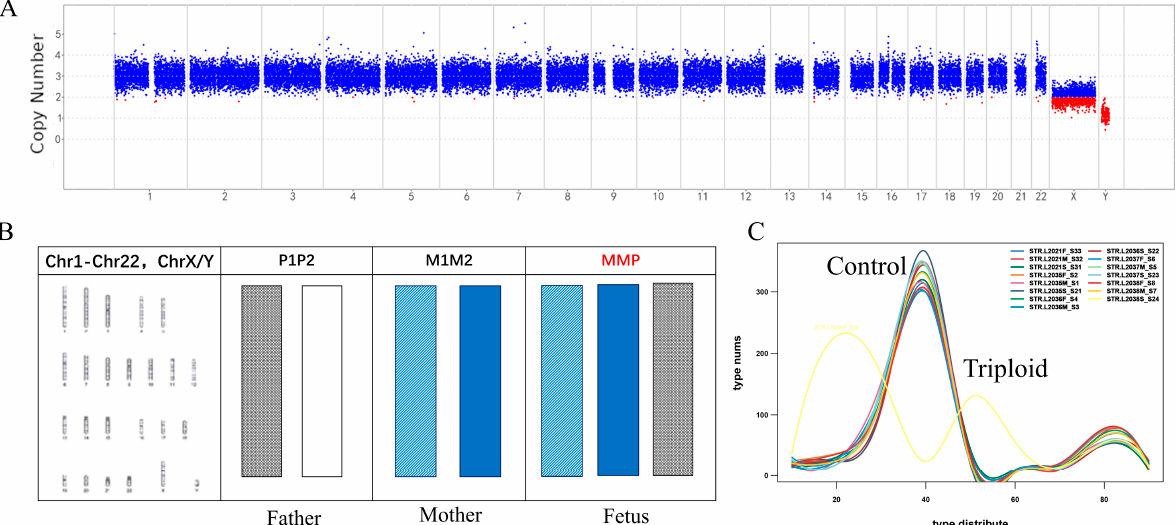
Figure 4. Results of CNV-seq and STR panel detection of triploid miscarriage samples. ( A ) Plot of CNV-seq detection results of the 69, XXY triploid. ( B ) Chromosomal G-banding and STR detection results of miscarriage triploidy. ( C ) The control curve represents the proportion of chromosomal STR loci tested that are identical to the constructed chromosomal haplotype STR loci of approximately 50%. The triploidy curve represents the concordance of approximately 30% of the detected chromosomal STR loci with the constructed paternal chromosomal haplotype STR loci and approximately 60% with the constructed maternal chromosomal haplotype STR loci.